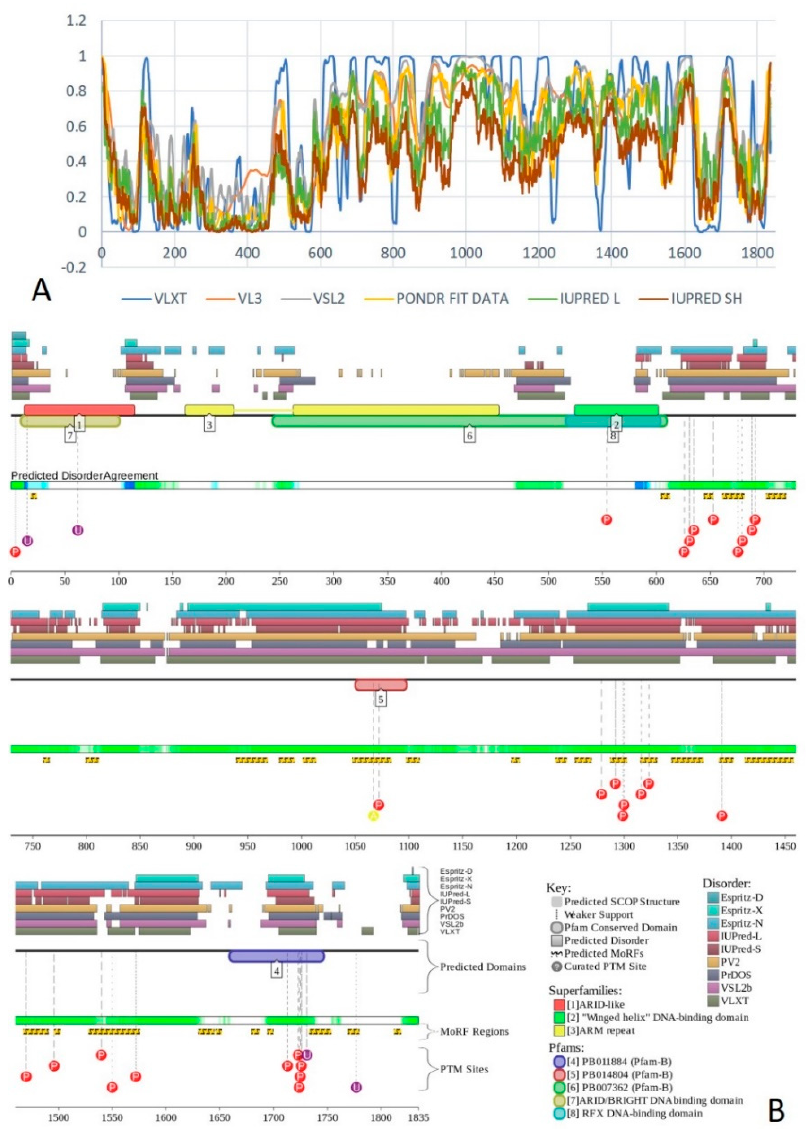
Figure 17. Structural and functional analysis of the human BAF200/ARID2 protein (UniProt ID: Q68CP9). ( A ) Intrinsic disorder profile of human BAF200/ARID2 protein generated by six commonly used predictors of intrinsic disorder (PONDR ® VLXT, PONDR ® VL3, PONDR ® VSL2, PONDR ® FIT, IUPred_short, and IUPred_long). ( B ) D 2 P 2 functional disorder profile of the human BAF200/ARID2 protein.